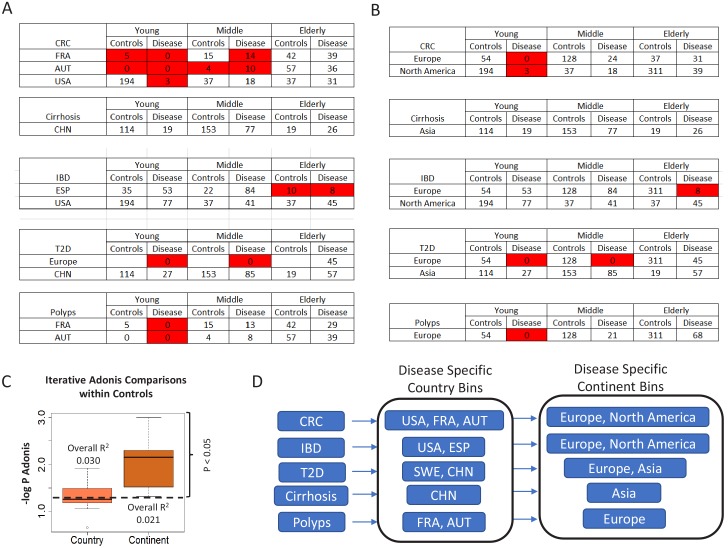
Number of control and diseased individuals belonging to the different age-groups present in (A) country-specific and (B) continent-specific groups pertaining to each disease.Age-groups where the number of control/diseased samples are less than 15 are highlighted in red. The shortened notations for the different country used are ESP: Spain; USA: United States, CHN: China, SWE: Sweden, AUT: Austria, FRA: France (C) Boxplots comparing the PERMANOVA -log P-values obtained for the effects of the geographical factors, country and continent, by taking repeated subsets of control samples (n = 25, subset size = 20%). The overall R2 value obtained for the PERMANOVA is also indicated. While R2 was higher for country, the p-values obtained for continent was significantly lower as compared to country, indicating that the effect of continent is much more significant than the country. The results indicated that country and continent had similar effects on the microbiome. (D) The country and continent specific cohorts within which the analyses were restricted for each disease, to take into account the regional variations.